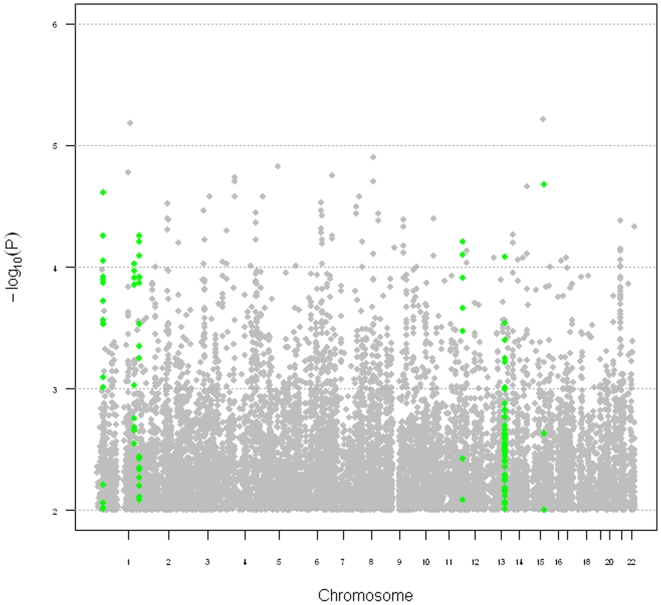
Summary of GWAS results from the Oregon-SUDS population.Chromosome is on the X-axis and the negative log of the P value is on the Y-axis. Regions meeting criteria for follow-up in ARIC/CHS are highlighted in green.